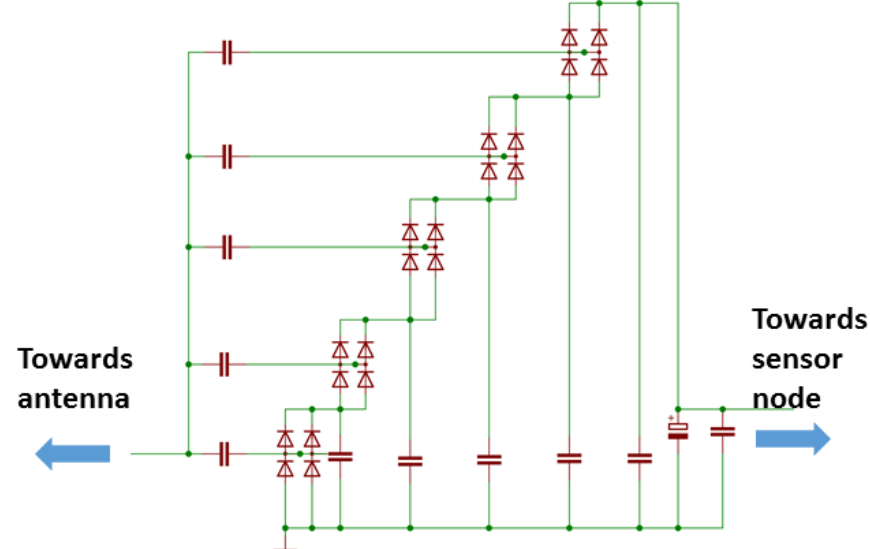
Figure 11. Schematic of the radio frequency to direct current converter board.